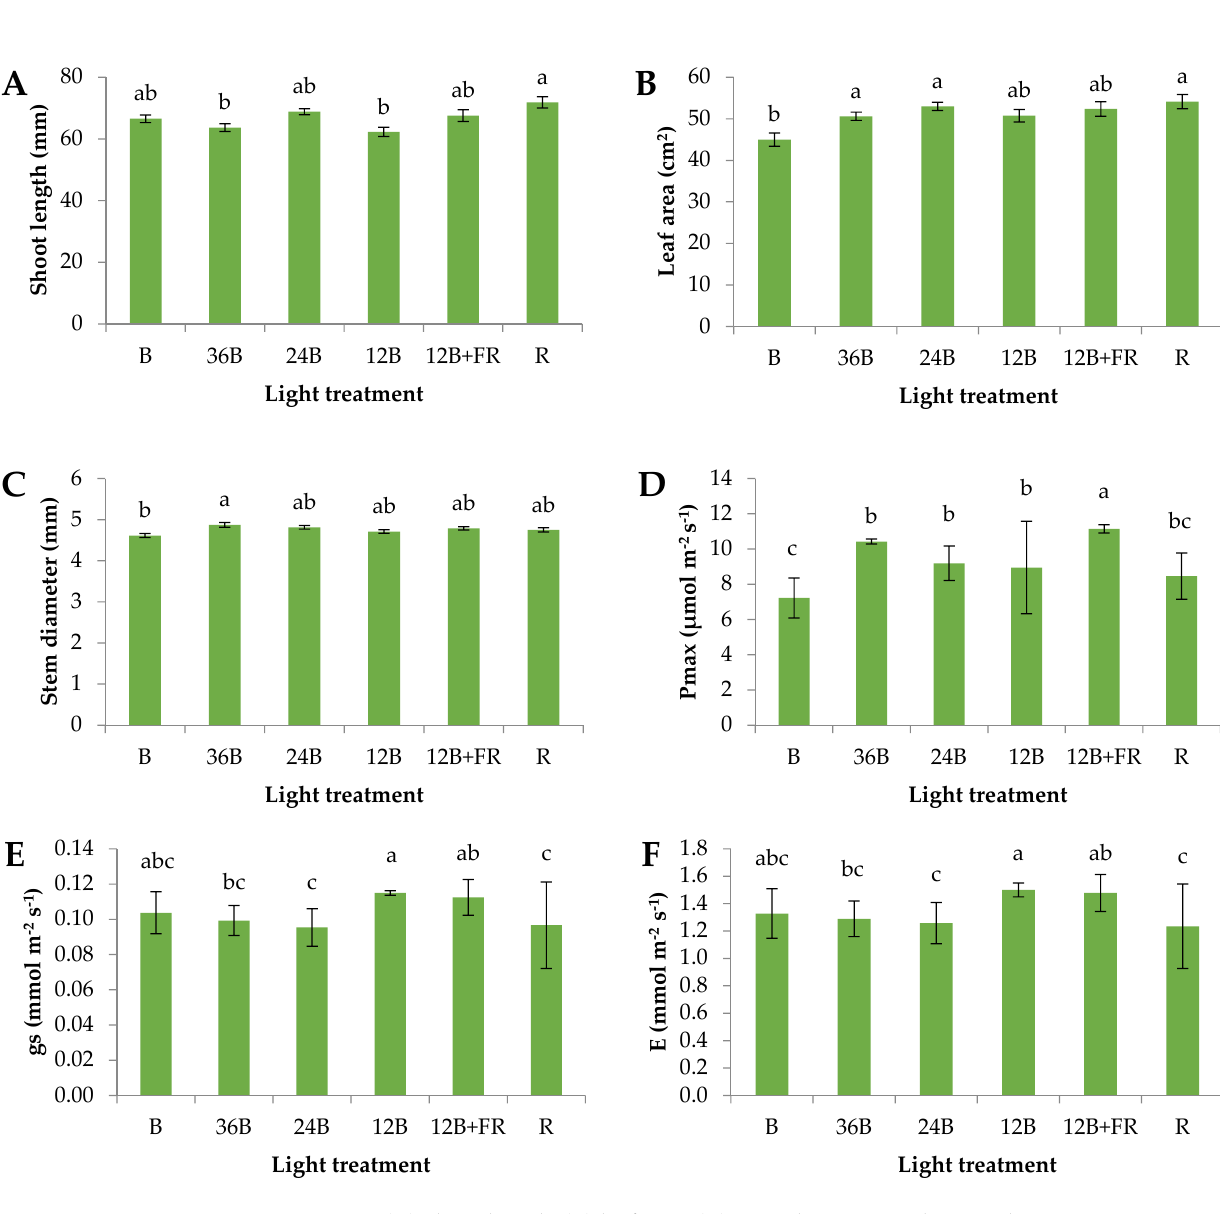
Figure 3. ( A ) Shoot length, ( B ) leaf area, ( C ) stem diameter, and gas exchange parameters such as ( D ) maximum photosynthetic rate, ( E ) stomatal conductance, and ( F ) transpiration rate of grafted watermelon seedlings treated for seven days in a healing chamber with six light treatments, plus seven days in a greenhouse. Pmax: maximum photosynthetic rate; gs: stomatal conductance; E: transpiration rate. Mean values ( ± SE) within a row followed by different letters are significantly different (a < 0.05).